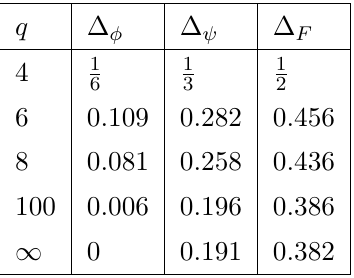
Table 1. Conformal dimensions of (cid:12)elds for various values of q